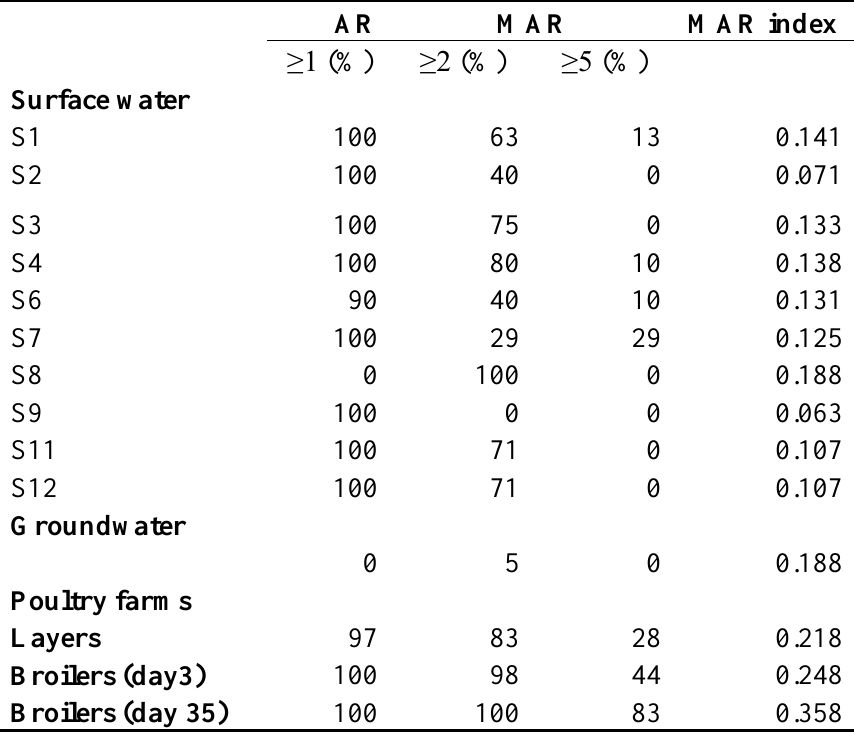
Table 4. AR, MAR and MAR indices for enterococci